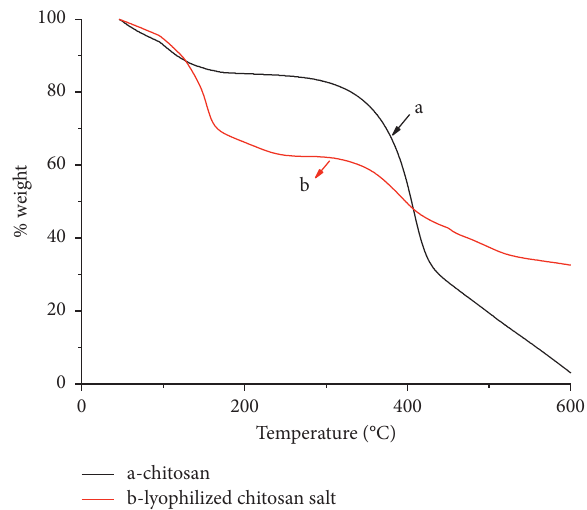
Figure 9: Thermogravimetric analysis (TGA) of lyophilized chi- tosan salt and conventional chitosan.